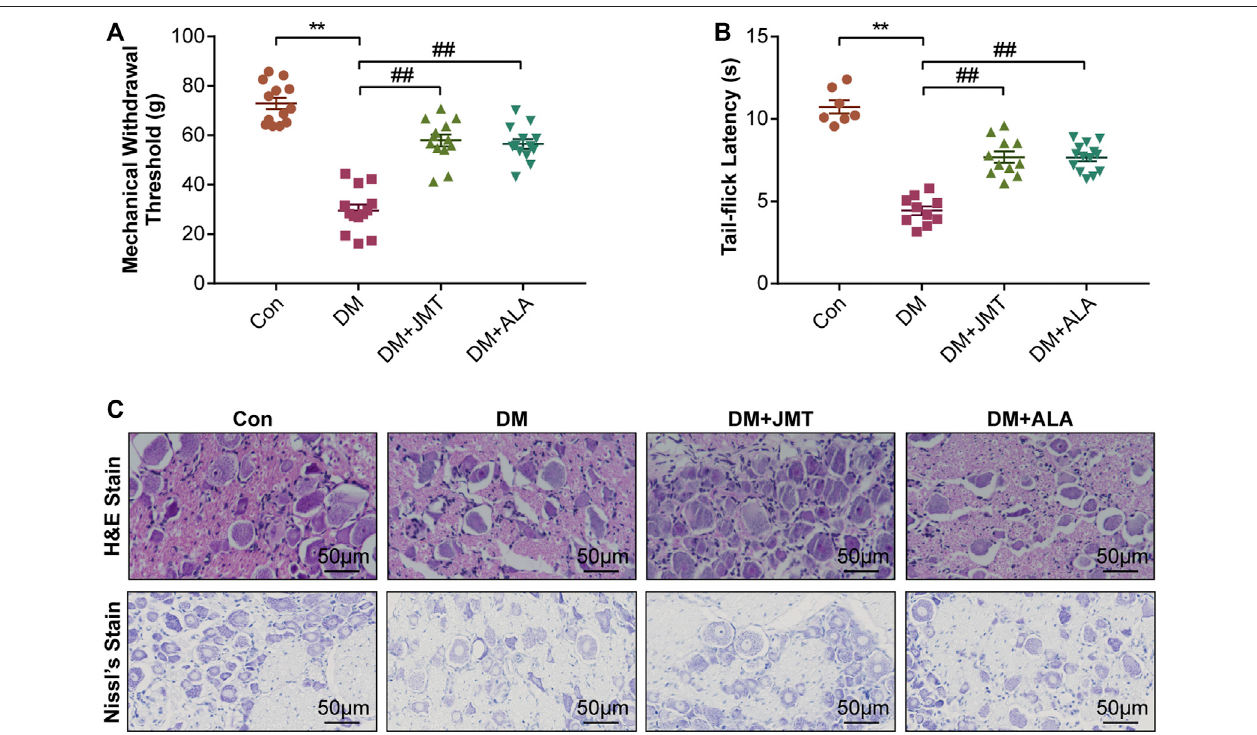
FIGURE2| EffectsofJMTonDNPphenotypesindiabeticrats (A) Mechanicalwithdrawalthreshold(MWT)andtail- fl icklatency(TFL)levels (B) wereassessedafter 12 weeks of treatment. Representative images of (C) hematoxylin and eosin (H&E) and Nissl ’ s staining of Dorsal root ganglia (DRG) in different groups (magni fi cation, × 400; scale bars: 50 μ m). The data are presented as mean ± SEM (n (cid:1) 8 per group). ** p < 0.01 vs Con group, ## p < 0.01 vs DM group. Con, control; DM, diabetes mellitus; ALA, alpha-lipoic